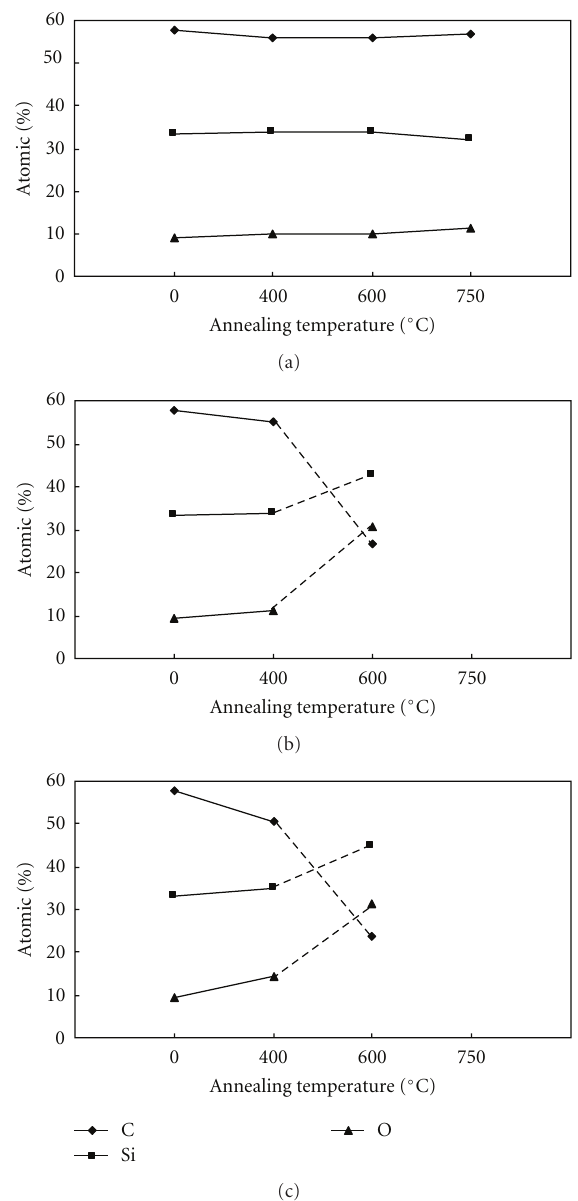
Figure 4: Relative atomic content of DLC-Si–O films with 2Pa annealed in (a) vacuum, (b) argon, (c) air.